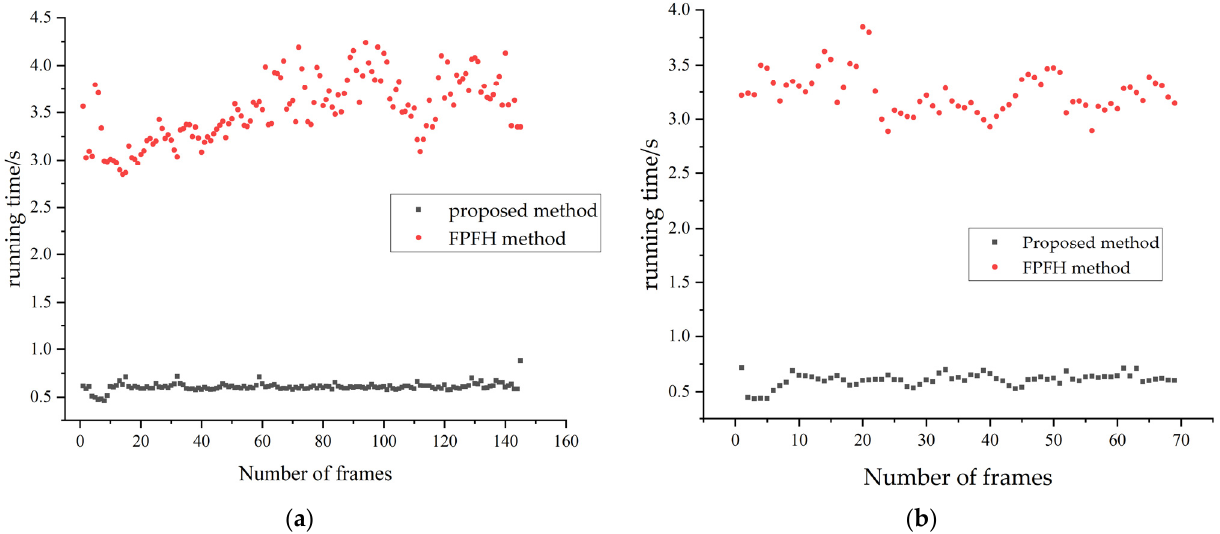
Figure 20. Comparison of the computational time between the proposed method and the FPFH method in rotation experiments: ( a ) low-speed experiment; ( b ) high-speed experiment.